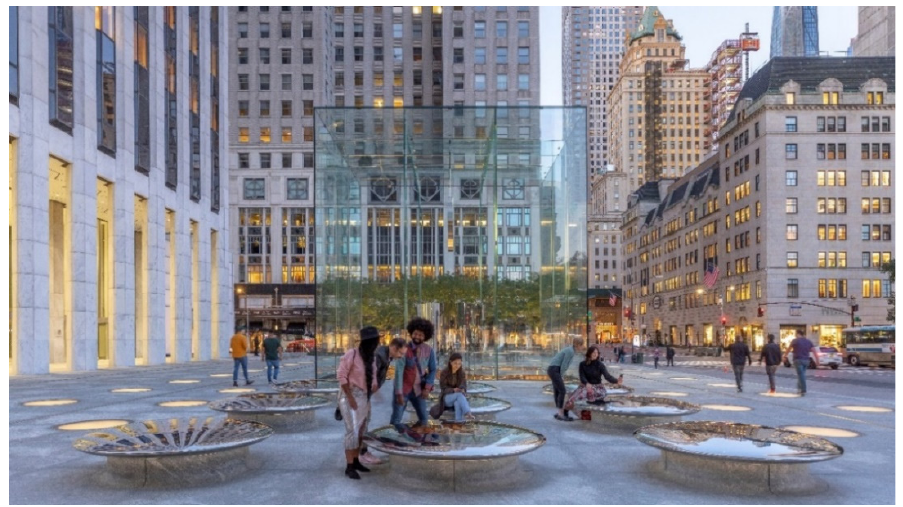
Figure 11. The Fifth Avenue Glass Apple Cube in New York (© Aaron Hargreaves/Foster + Part- ners).